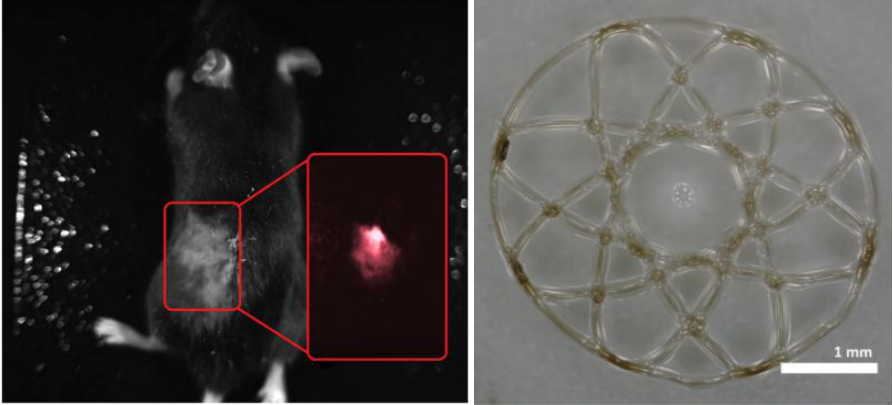
Fig. 1. Left: Bright-field photo of mouse with implanted nanohybrid scaffold on day 1. The inset shows epiluminiscent signal from scaffold under irradiation at 980 nm wavelength. Right: Scaffold structure produced by direct laser